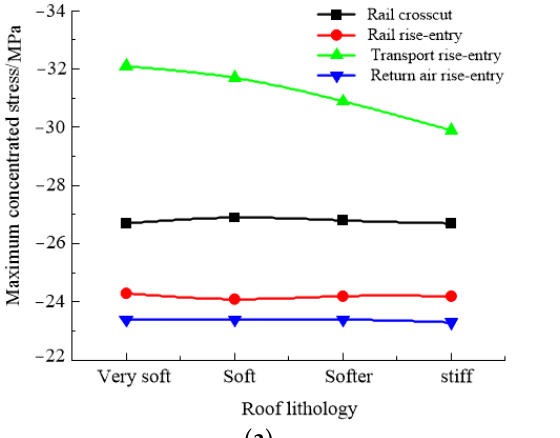
( b ) Figure 8. Monitoring results of convergence in roadway-concentrated areas under different roof lithology conditions. ( a ) Roof-to-floor convergence, ( b ) Two-sided convergence. It can be seen from Figure 8 that in the roof-to-floor convergence, affected by the roof lithology, each roadway showed a trend of decreasing first and then increasing. As for the